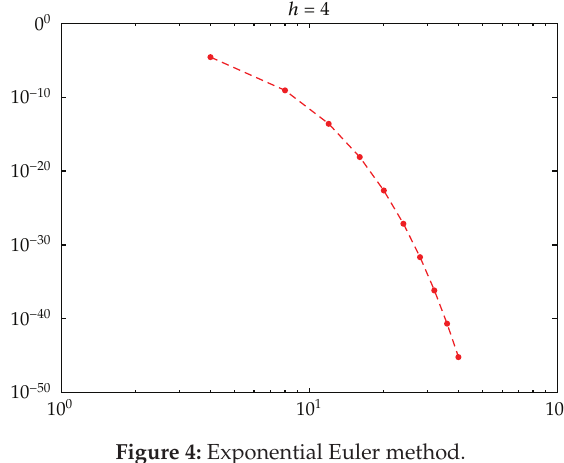
Figure 4: Exponential Euler